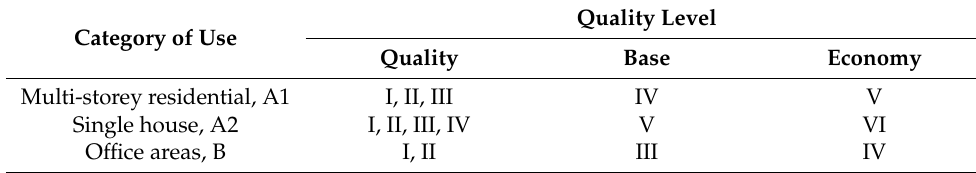
Table 2. Floor performance level according to the category of area use and quality class.